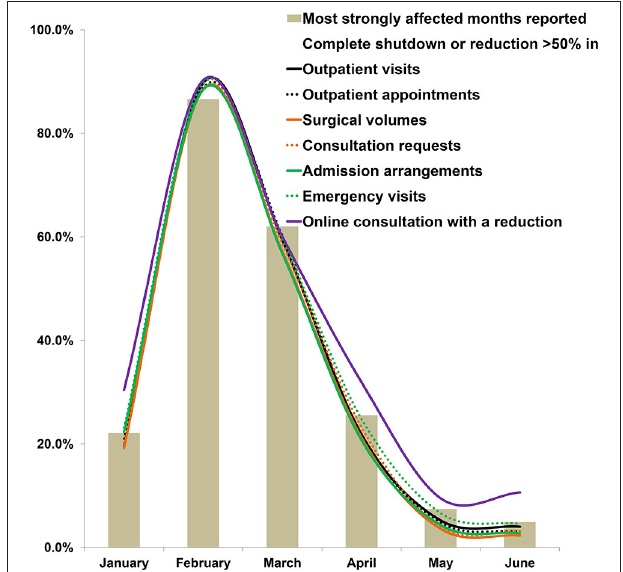
FIGURE 1 | The periods most affected during the COVID-19 pandemic and clinical activities with a > 50% reduction or a complete shutdown as reported by physicians. The ratios have been